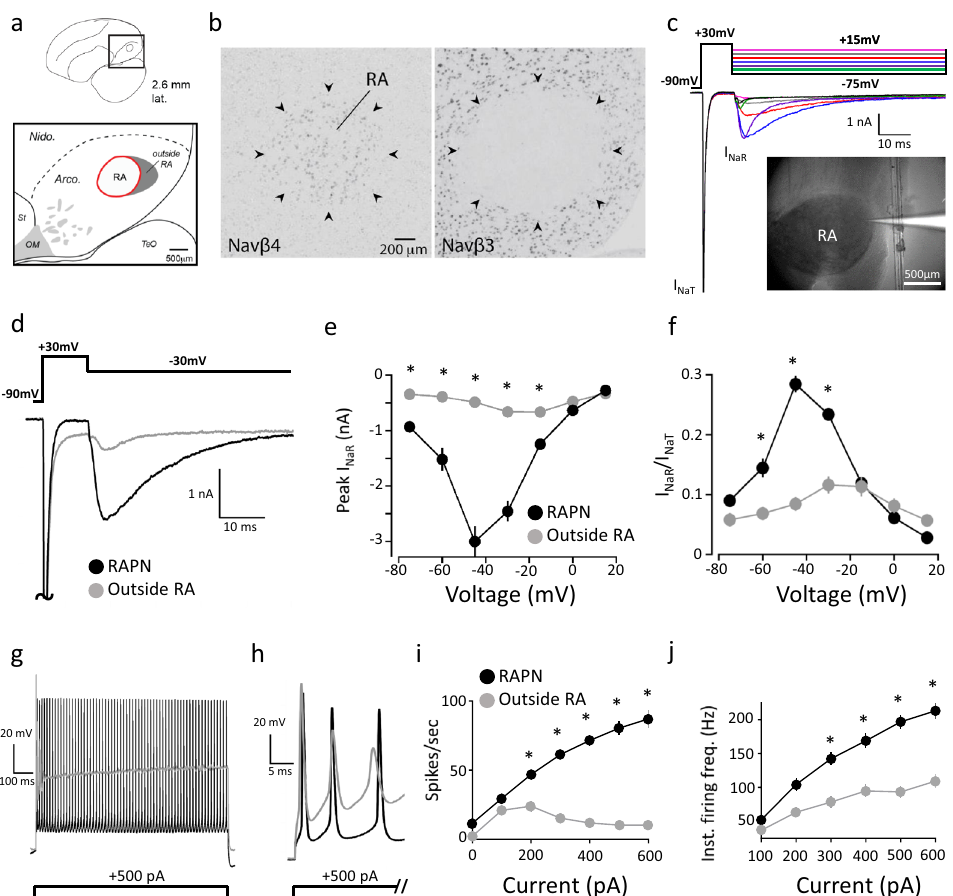
Fig. 2 Expression of Nav β 4 and β 3 mRNAs, resurgent Na + current ( I NaR ), and the spiking properties of RAPNs in the arcopallium of adult male zebra fi nches. a Anatomical drawing indicating the position of RA within the arcopallium in a parasagittal section; distance from the midline indicated; the shaded area represents the region outside RA that is compared with recordings within RA. Arco., arcopallium; Nido., Nidopallium; OM, occipitomesencephalic tract; St, striatum; TeO, Optic tectum. Orientation: dorsal is up and anterior to the left. Adapted from Karten et al. 133 . b In situ hybridization images show high Nav β 4 expression (left) and lack of Nav β 3 expression (right) in RA (indicated by arrowheads). Each image is one of four replicates quanti fi ed in Fig. 3i – l. c Representative examples of I NaT and I NaR elicited in an RAPN at 24°C by the voltage clamp protocol at the top. I NaT was elicited via a 10ms step to + 30 mV followed by test potentials to + 15 (pink), 0 (gray), − 15 (red), − 30 (blue), − 45 (purple), − 60 (green), and − 75mV (black) to elicit I NaR . The cell was held at − 90 mV during a 2 s intersweep interval. Inset: Image of a patch pipette fi lled with fl uorescent dye for RA recordings. Quanti fi ed in 1e. d Detail views of example I NaT and I NaR elicited in an RAPN (black) and in a neuron outside RA (gray) by the voltage clamp protocol at the top. The I NaT peaks have been truncated. e Average I – V curves for the peak I NaR in RAPNs (black) and in neurons outside RA (gray) (two-way ANOVA with Tukey ’ s post hoc; P